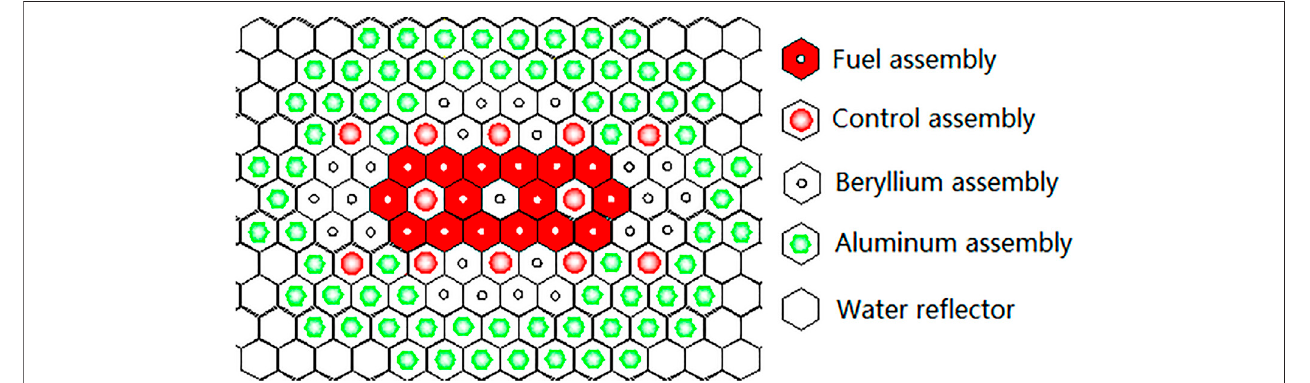
FIGURE 11 | Core arrangement of Scheme 9A.